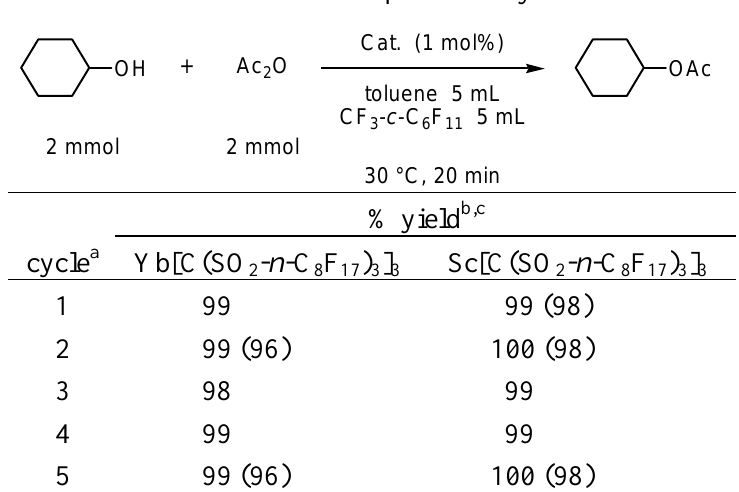
Table 1. Fluorous biphasic acetylation.